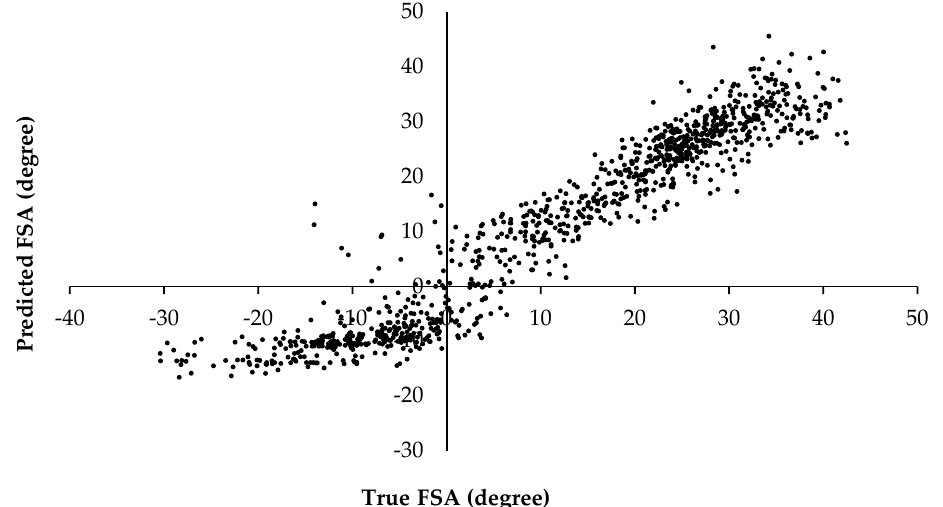
Figure 4. The relationship between the true foot strike angle (FSA) and that predicted by the multiple regression is shown for the distribution of the foot falls included in the study. The strike patterns can be discerned from the following scale: fore foot: FSA < − 1.6 ◦ ; mid foot: − 1.6 ◦ ≤ FSA ≤ 8.0 ◦ ; rear foot: FSA > 8.0 ◦